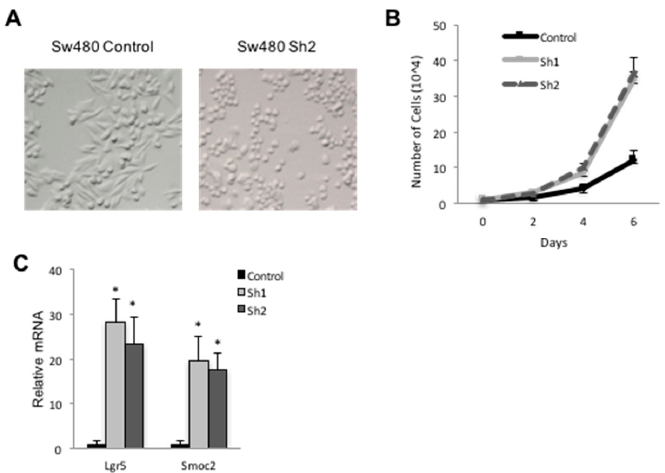
Figure 5. Cdx2 knockdown increased expression of intestinal stem cell markers. ( A ) SW480 cells from control and Cdx2 Sh knockdown cells. Note the lack of elongated cells in the knockdown culture. ( B ) Growth curve for control and Cdx2 Sh knockdown cells. ( C ) RT-PCR from for stem cell markers in control and Cdx2 knockdown SW480 cells. Error bars represent standard deviation from the mean expression levels of three independent samples. * p < 0.05 by Student’s t -test. Intestinal stem cells, or early progeny thereof, are thought to be the cells of origin in CRC [42]. Gene expression analyses revealed an increase in the intestinal stem cell markers Lrg5 and Smoc2 in lines lacking Cdx2 (Figure 5C), suggesting that cells deficient in Cdx2 exhibit a more stem-like character. Finally, Cdx2 knockdown SW480 cells formed typical retractile colonies in soft agar, while wild type SW480 cells formed smaller colonies (Figure 6A). The Cdx2 knockdown cells also formed significantly more (Figure 6B) and larger (Figure 6C) colonies relative to controls, consistent with a tumor-suppressive function of Cdx2 in this cell line.